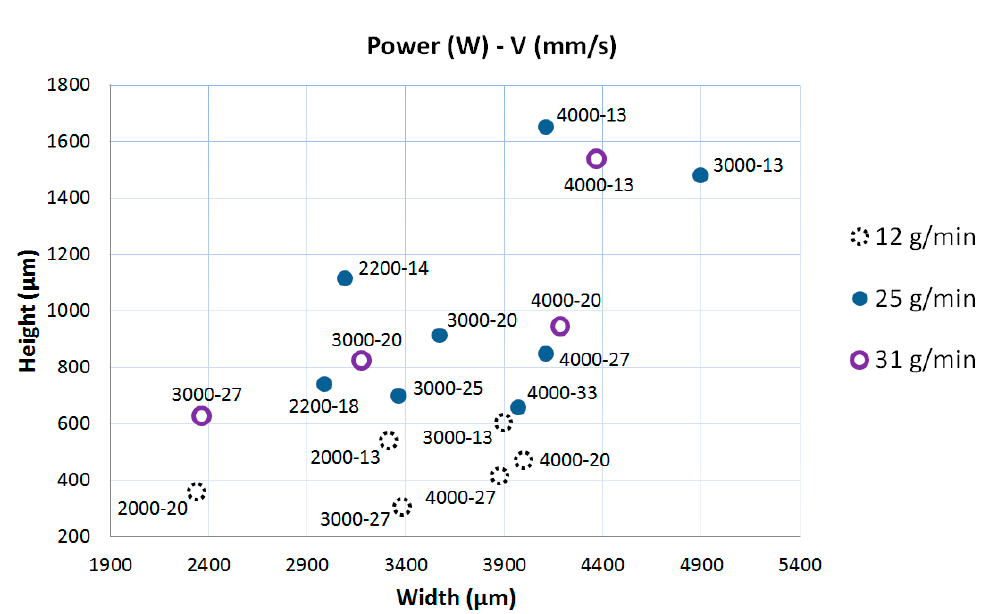
Figure 3. Dimensions of clads (height vs width) with their process parameters inside the graphic (Power (W)-V (mm/s)).